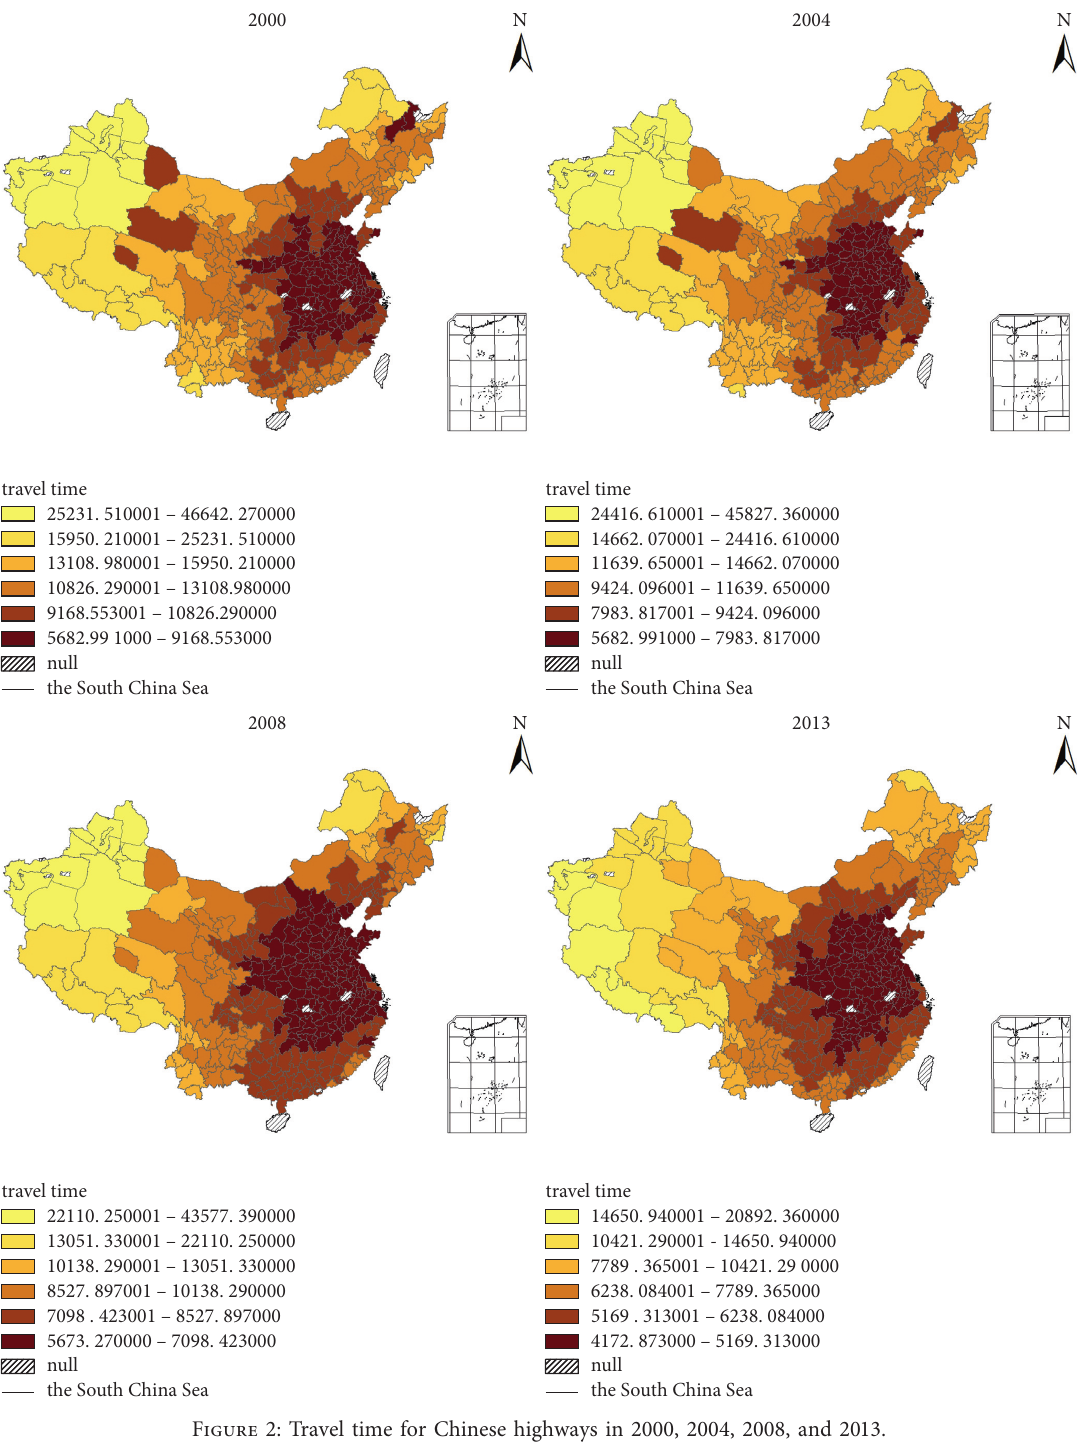
Figure 2: Travel time for Chinese highways in 2000, 2004, 2008, and